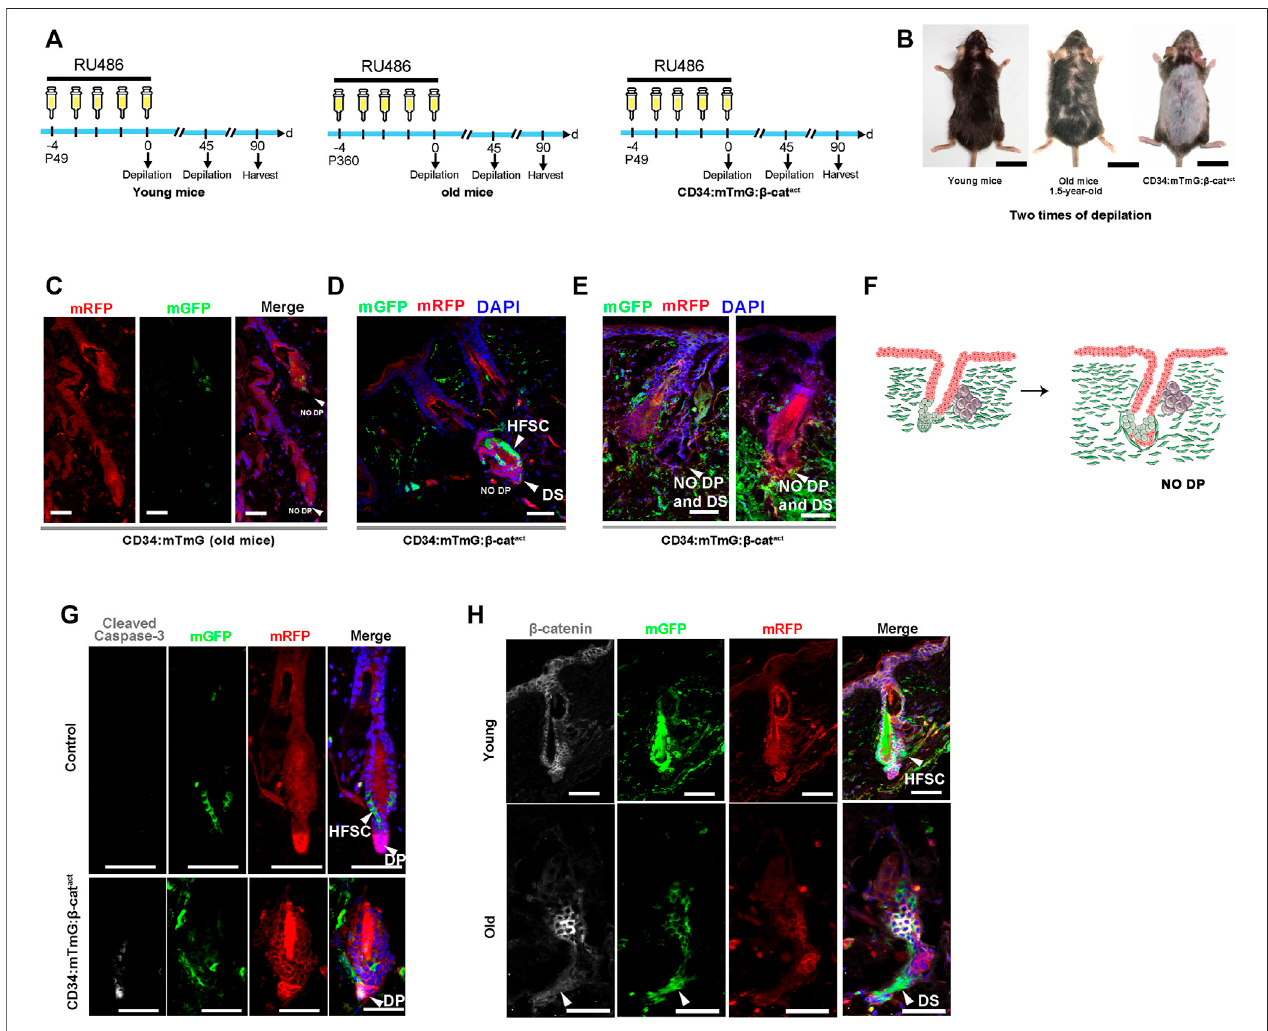
FIGURE 5 | Ectopic activation of β -catenin leads to senescent HFs without DP cells. (A) Experimental timeline of RU486 injections and analysis in young CD34: mTmG, old CD34:mTmG, and CD34:mTmG: β -cat act mice. (B) Young CD34:mTmG (left panel), old CD34:mTmG (middle panel), and CD34:mTmG: β -cat act mice (right panel) that had undergone depilation-induced hair cycle twice. (C) Skin sections of 1.5-year-old CD34:mTmG mice. (D,E) CD34:mTmG: β -cat act skin sections showing HFs without DP cells. Note that there was a ring of DS cells at the bottom of the HF, but the HFs did not contain DP. (F) Schematic illustration of the evolution of senescent HFs without DP cells. (G) CD34:mTmG: β -cat act and CD34:mTmG skin immunostained for anti-cleaved caspase-3 antibody (white). Arrowhead highlights cleaved caspase-3 expression in DP cells. (H) CD34:mTmG: β -cat act and CD34:mTmG skin were immunostained for β -catenin (white). Note elevated β -catenin expression in hfDSCs. Scale bars, 2 cm (B); 50 μ m (C – H) .